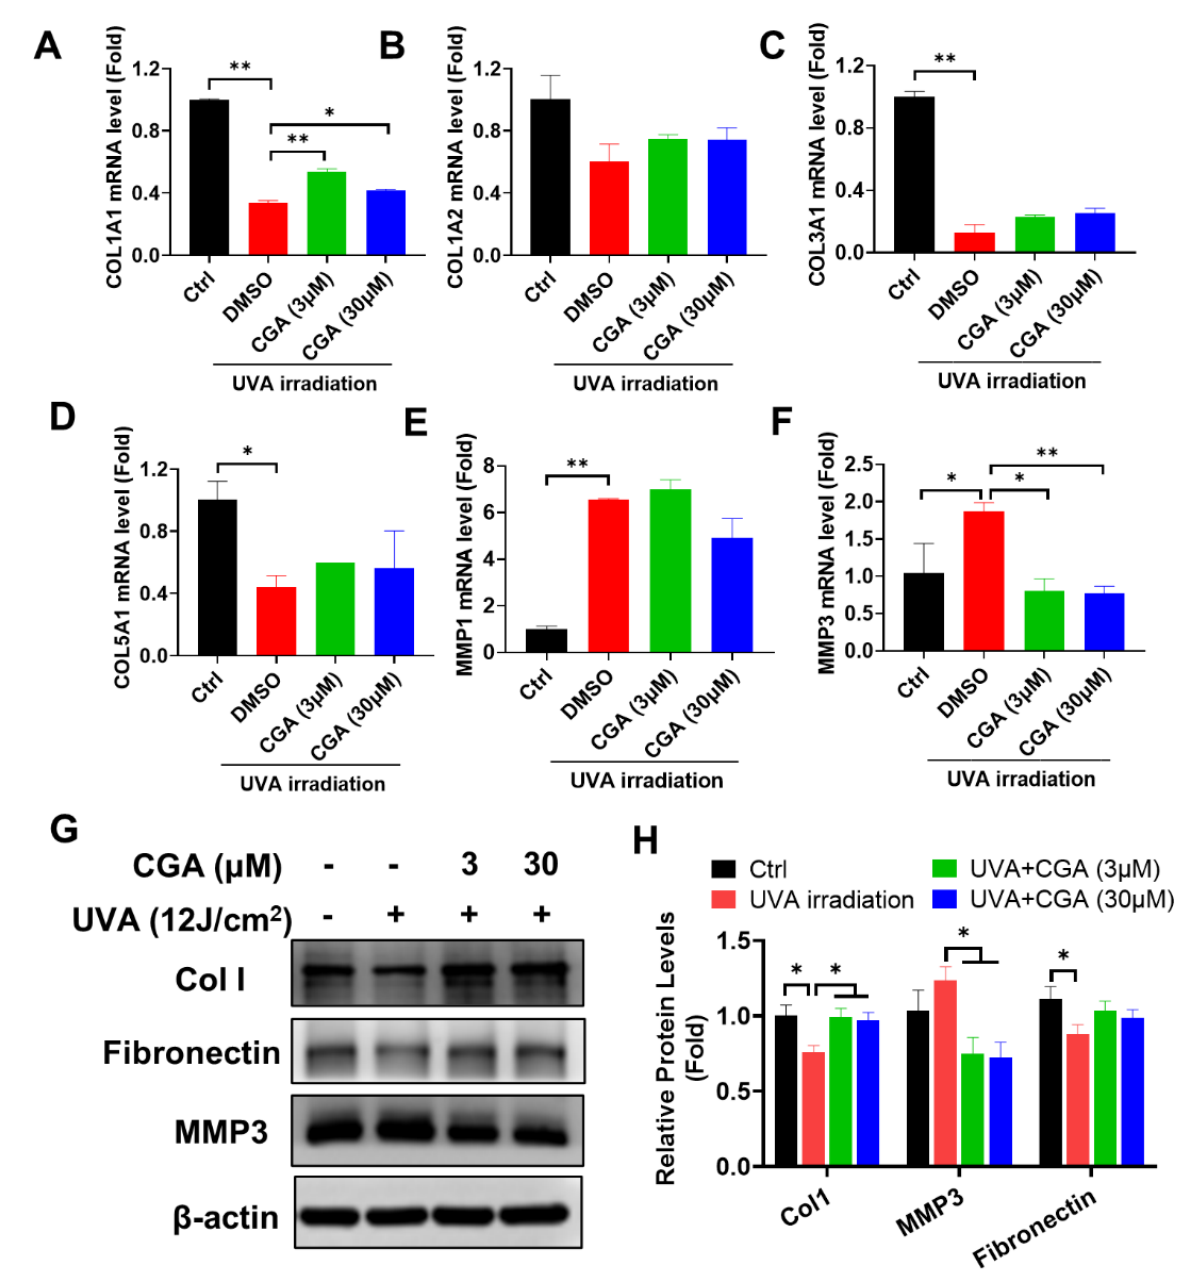
Figure 4. The effect of CGA on collagen I metabolism in UVA-irradiated HDF- α cells. The mRNA levels of Col1A1 ( A ), Col1A2 ( B ), Col3A1 ( C ), Col5A1 ( D ), MMP1 ( E ) and MMP3 ( F ) in UVA-irradiated HDF- α cells were detected by qRT-PCR. Data represent the mean ± SD of three independent measurements. * p ≤ 0.05, ** p ≤ 0.01 indicate a significant difference. ( G ) The Col1, MMP3 and fibronectin protein expressions in UVA-irradiated HDF- α cells were measured by western blot assay. ( H ) Relative protein expressions were quantified by densitometry and shown in the histogram. The results represent the averages of three independent experiments. * p ≤ 0.05 indicate a significant difference.